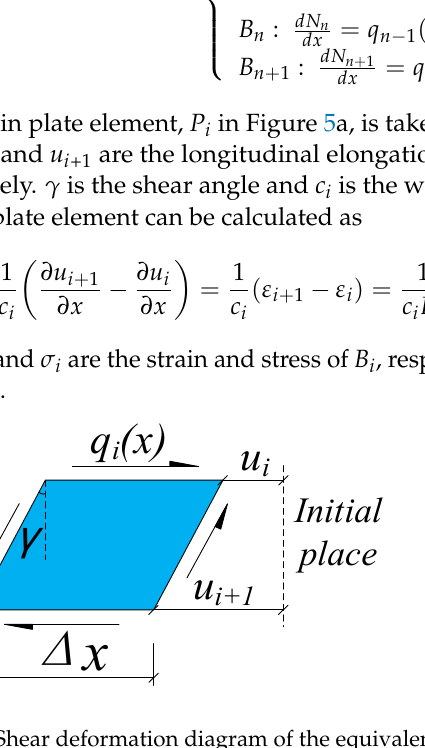
Figure 6. Shear deformation diagram of the equivalent plate micro-element.